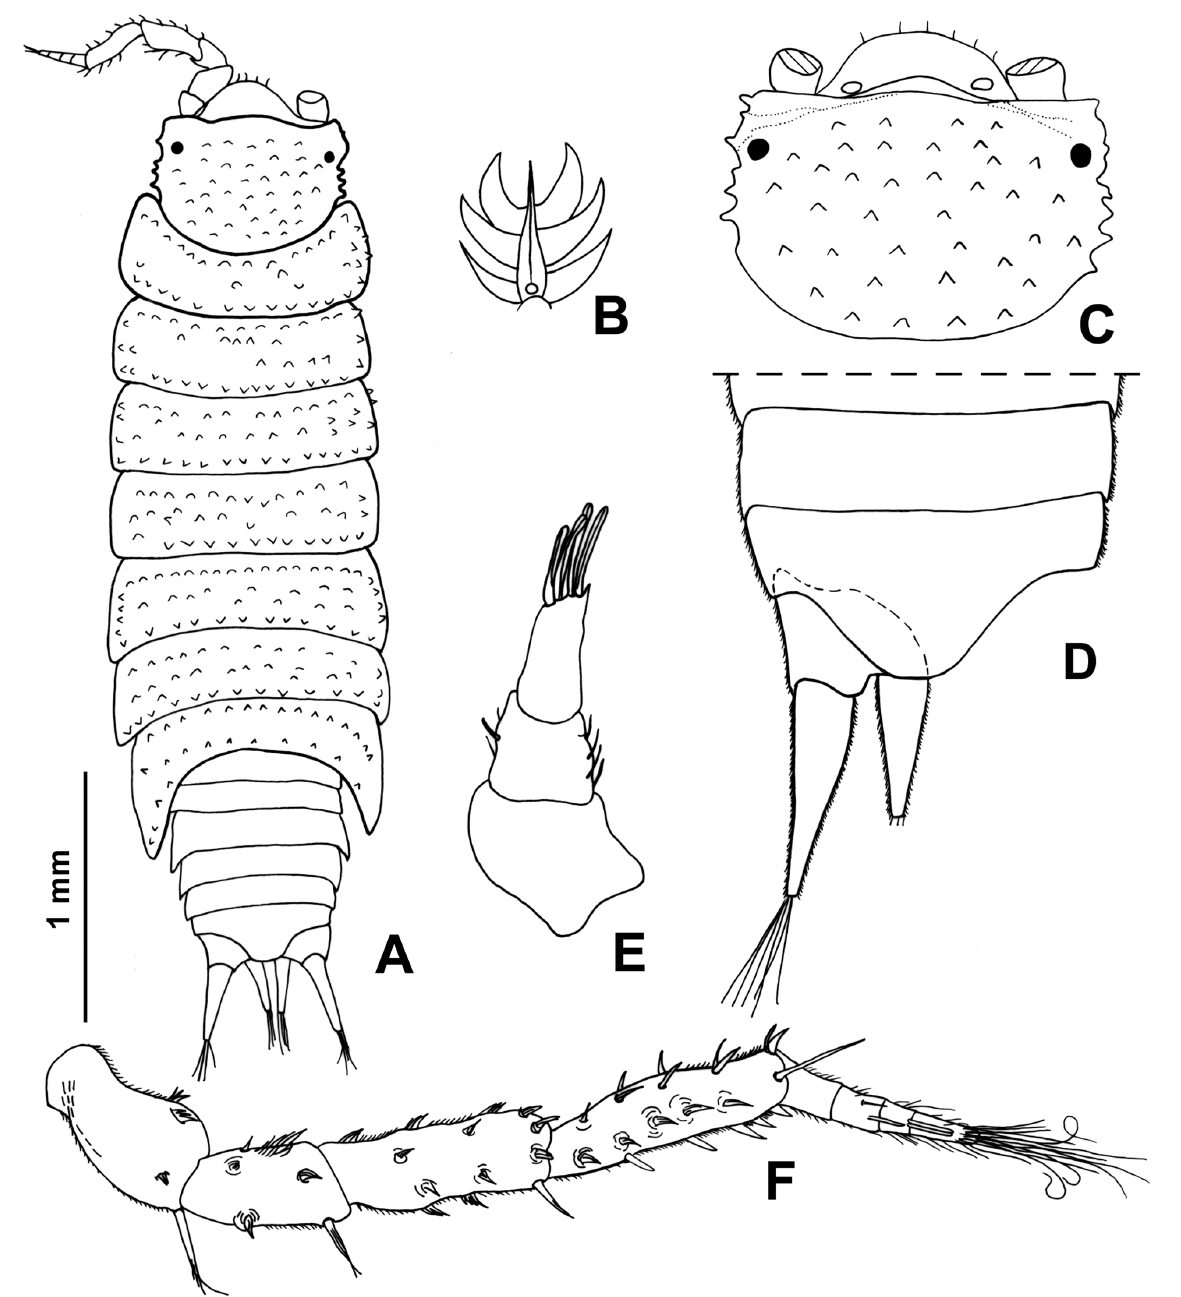
Fig. 18. Miktoniscus longispina Reboleira & Taiti sp. nov. from Gruta dos Bolhos, Cesaredas Plateau. — Paratype, ♀. A . Specimen in dorsal view. — Paratype, ♂. B . Dorsal scale-seta. C . Cephalon in dorsal view. D . Pleonite 5, telson and left uropod. E . Antennula. F .